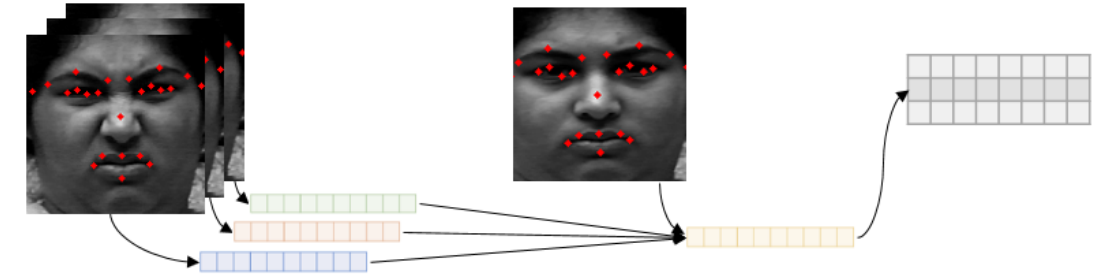
Figure 10. The input vector for the geometric feature-based